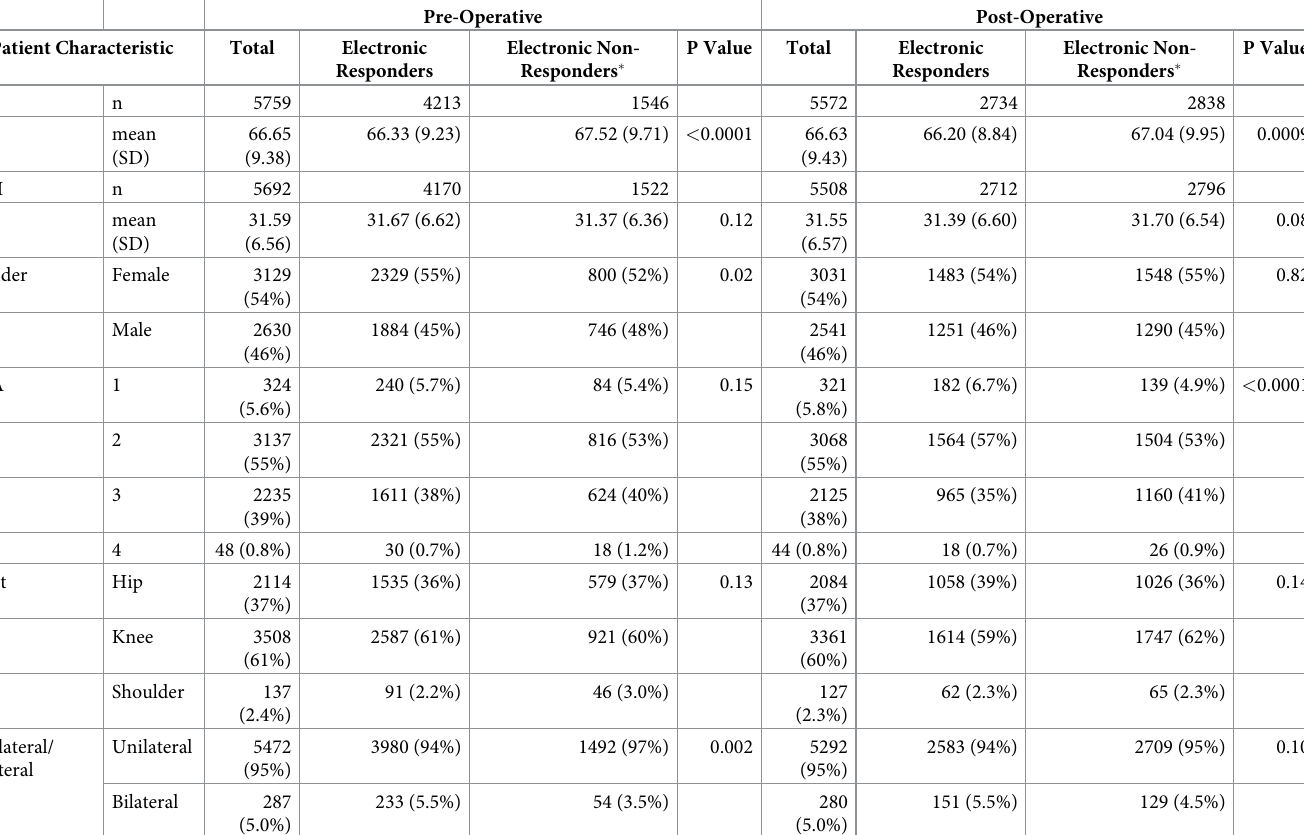
Table 1. Demographic and clinical comparison of patients providing electronic data entry (“responders”) to those not providing data electronically (“electronic non-responders” �